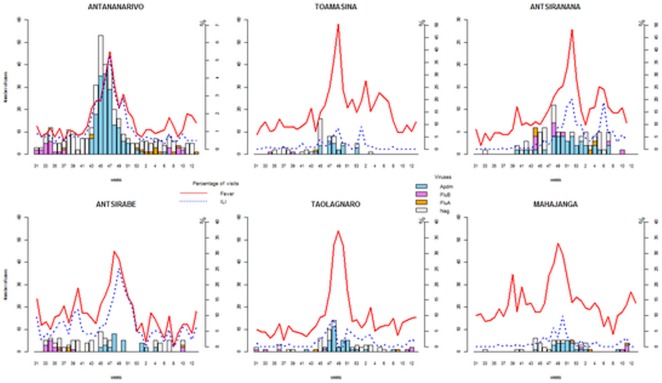
Time series distribution of the fever syndromes, ILI and confirmed influenza cases in the major cities of Madagascar.